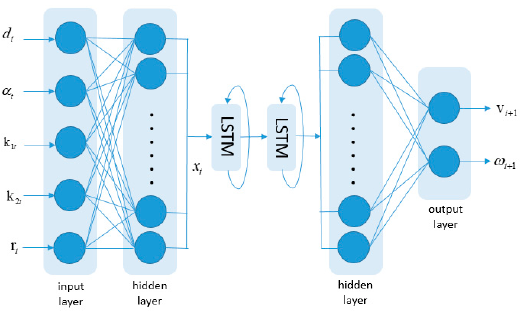
Figure 5. Architecture of the proposed LSTM model.